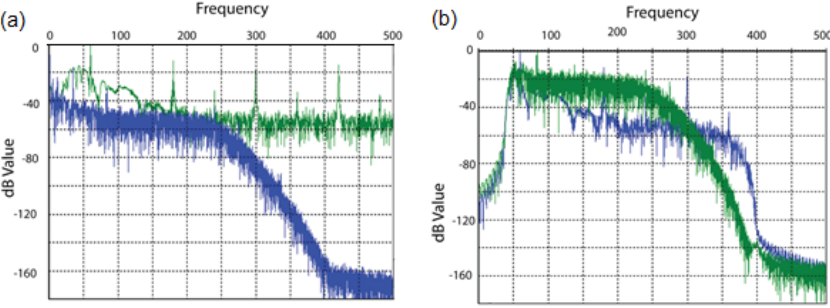
Figure 17. Comparison of vibration signals between ( a ) the reference geophone (blue) and the fiber-optic cable (green); and ( b ) the reference geophone (blue) and the buried (approximately 15 cm under the surface) fiber-optic cable (green)